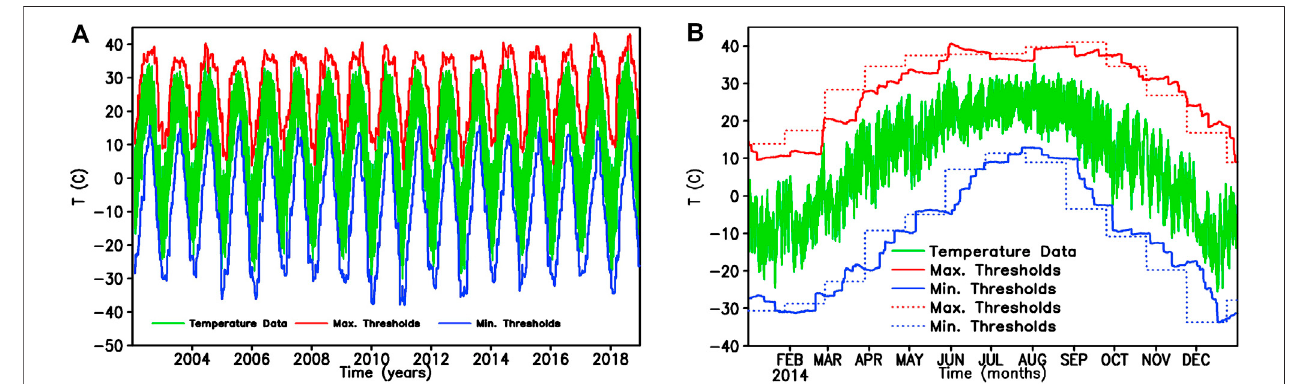
FIGURE5| The resultsofthethreshold testmethodfor temperature (Unit: ° C)at SBstation (A) from 1January 2002to31December 2018and (B) from 1January 2014 to 31 December 2014.(The hourly temperature data (green line); the upper limits per hour (the maximum thresholds, red line) and the lower limits per hour (the minimum thresholds; blue line) obtained from our algorithm, the upper limits per 30 days (the maximum thresholds; the red dotted line) and the lower limits per 30 days (the minimum thresholds; the blue dotted line) obtained from the previous threshold test method).